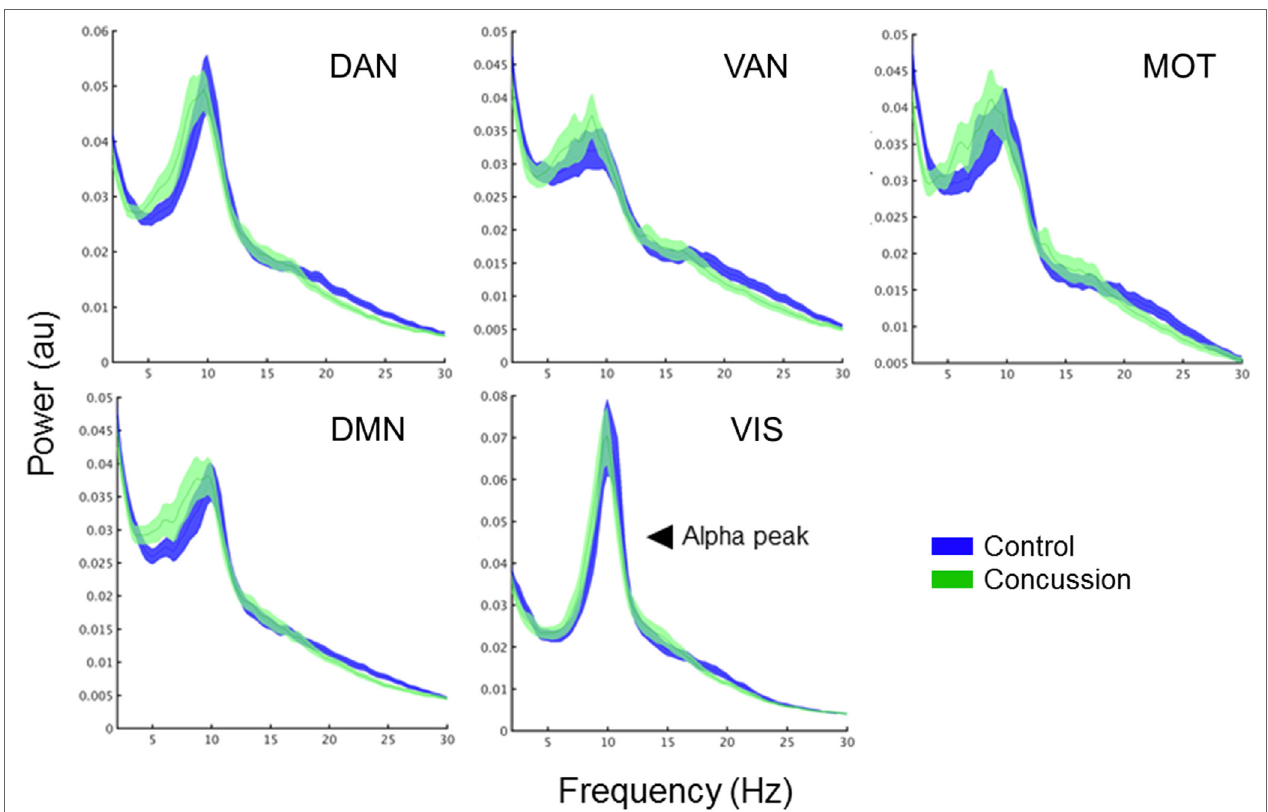
FigUre 3 | Band-specific ICN connectivity mediated by AEC. Scatter plot dots show intra-subject mean across epochs, black line represents median over participants for each group in the DMN (left column) and MOTs (right), in the alpha (top row), beta (middle row), and gamma ranges (bottom row). * p corrected < 0.05. Connectivity matrices show edge weight differences (concussion minus controls) in respective ICNs—contrasts revealed the DMN increases in the concussion group were driven by ventro-medial prefrontal cortex (vmPFC) to right medial prefrontal cortex (rmPFC) and dorsal medial prefrontal cortex (dMPFC) connections. Abbreviations: AEC, amplitude envelope correlations; ICN, intrinsic connectivity network; DMN, default mode network; MOTs, motor